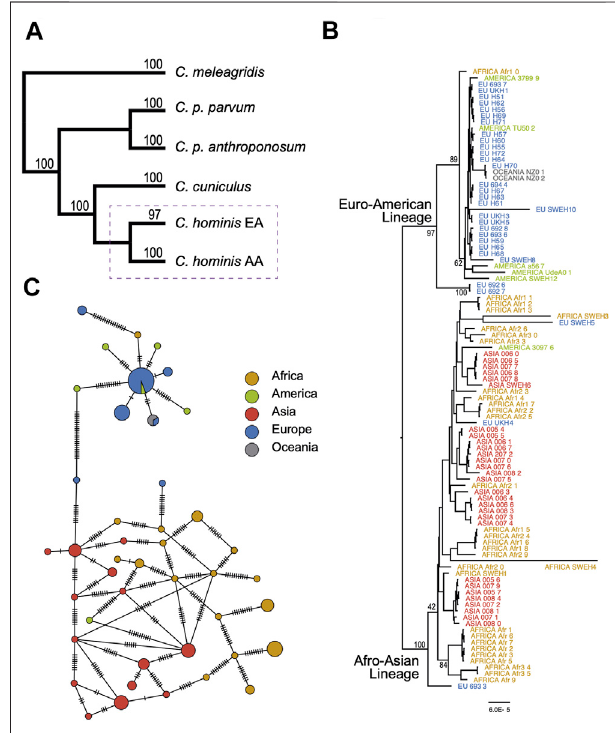
FIGURE 3 | Evolutionary relationships among species and populations of Cryptosporidium hominis . (A) Summary of main phylogenetic relationships among the main human-infecting Cryptosporidium species. The complete tree is provided in the Supplementary Material . The dashed rectangle is expanded in (B,C) . (B) Subtree depicting the phylogenetic relationships among C. hominis isolates from fi ve continents. Tree inference based on 61 coding genes and 140,425 sites. (C) Haplotype network based on 116 segregating sites across 61 coding genes (see methods for details). The size of the circles is proportional to the number of individuals with each haplotype. The cross lines represent the number of expected mutations among